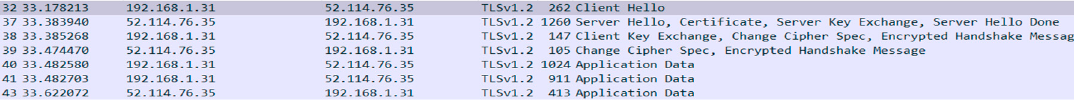
Figure 10. Packages that use the transport layer security (TLS)